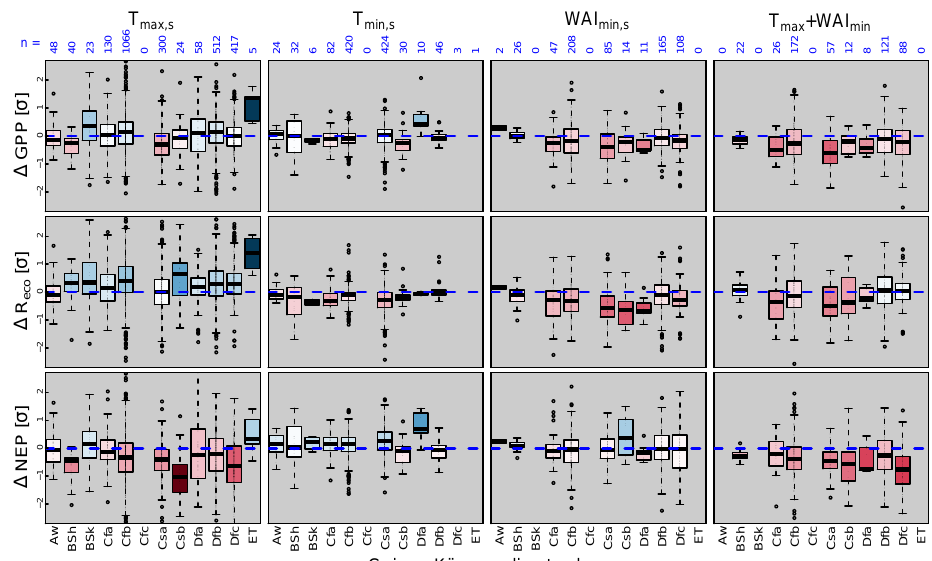
Figure 6. The influence of the ecosystem’s ecoclimatic zone on the extreme-event impact. Shown are the differences between z -transformed CO 2 fluxes during extreme events and reference periods ( (cid:49)z = z extr − z ref ; see Eqs. 2 and 3 for details) for the different extreme-event types and the different fluxes according to the Geiger–Köppen climate class (Table A2 for the abbreviations used) of the respective ecosystem. (See Fig. 4 for a detailed description of the box plots